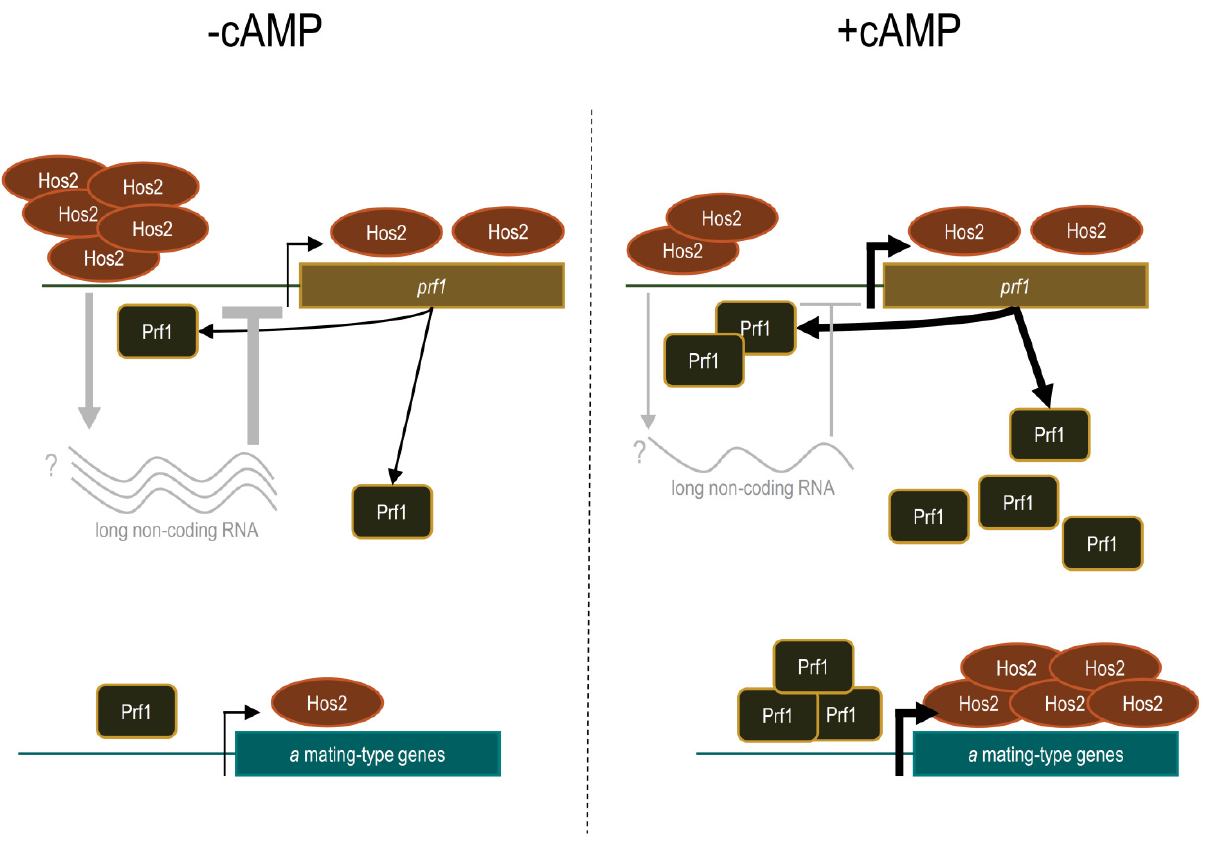
FIGURE 1: Working model for Hos2-dependent regulation of mating. During yeast-like growth and in the absence of cAMP (left), expression of prf1 and its target genes at the a mating-type loci is maintained at a low basal level just to allow cells of opposite mating types to be able to recognize each other. Hos2 binding to the gene bodies of mating genes might help to maintain this basal expression. During mating or after the addition of cAMP (right), the expression of prf1 and a genes increases significantly. Concomitantly, Hos2 binding to the gene bod- ies of a genes increases too, probably contributing to their transcriptional elongation and thus allowing efficient mating. Though Hos2 bind- ing to the prf1 gene body remains constant, it decreases at the UAS of its promoter. A plausible explanation for these results is the existence of a long non-coding RNA that inhibits prf1 expression during yeast-like growth (grey lines and